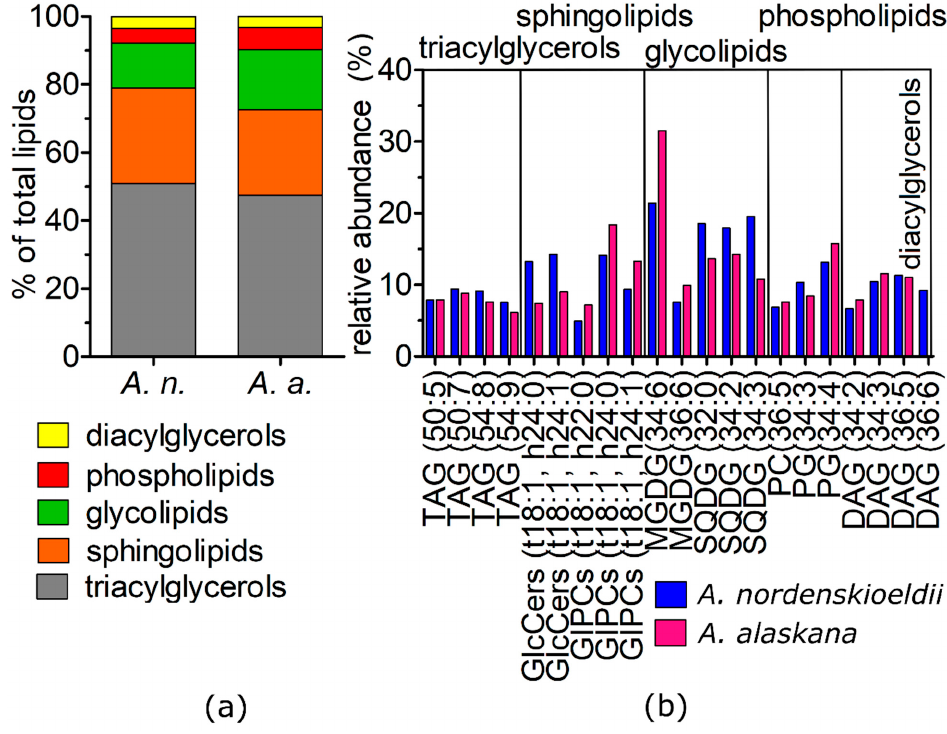
Figure 5. Cellular lipid composition of Ancylonema nordenskioeldii (WP211) and Ancylonema alaskana (WP167). ( a ) The relative proportions of lipid classes in (%) of total lipids. ( b ) The relative abundance of the most abundant lipid representatives of triacylglycerols (TAGs), sphingolipids (GIPCs, GlcCers), glycolipids (MGDG, SQDG), phospholipids (PG, PC),diacylglycerols (DAGs). The figure ( b ) shows only lipids that had abundances greater than 7% in a relevant lipid class. Microorganisms 2021 , 9 , x FOR PEER REVIEW